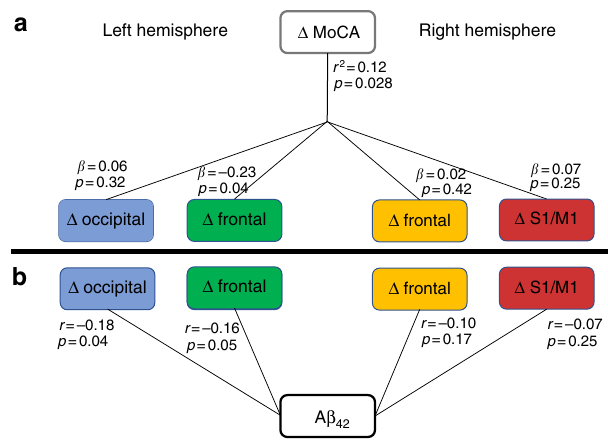
Fig. 5 Relation to markers of cognitive decline. a Linear regression model between changes (delta) in cortical thickness clusters and cognitive score (MoCA). The overall model was signi fi cant; speci fi cally, thinning of the left frontal cluster ( β = − 0.23, p = 0.03) and age ( β = 0.22, p = 0.01) were signi fi cantly related to decline in cognitive performance. b Partial correlations of CSF A β 42 with thinning of each cortical thickness cluster revealed signi fi cant correlations in the left hemispheric clusters. All analyses controlled for age and